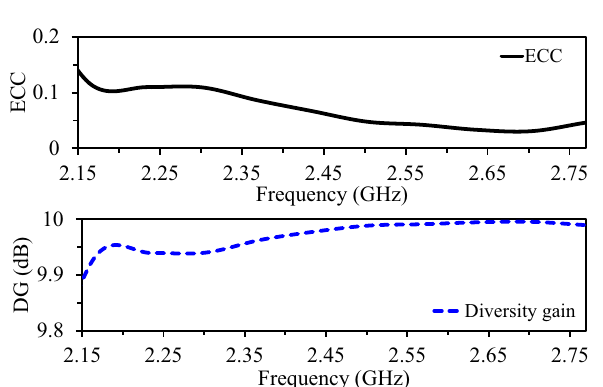
Figure 14. ECC and DG results of the suggested wideband implantable